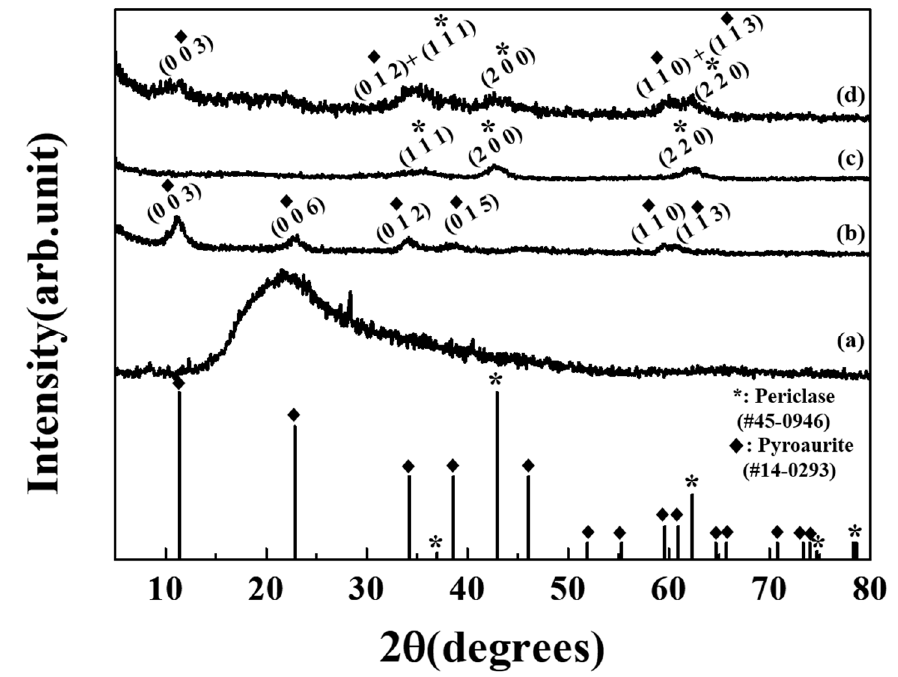
Figure 1. X-ray diffraction patterns of ( a ) Zingiber officinale extract (ZOE), ( b ) MgFe–LDH (layered Figure 1. X-ray di ff raction patterns of ( a ) Zingiber o ffi cinale extract (ZOE), ( b ) MgFe–LDH